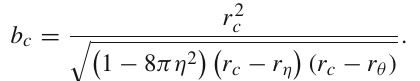
Fig. 6a. For η = 0 and θ (cid:10)= 0, we